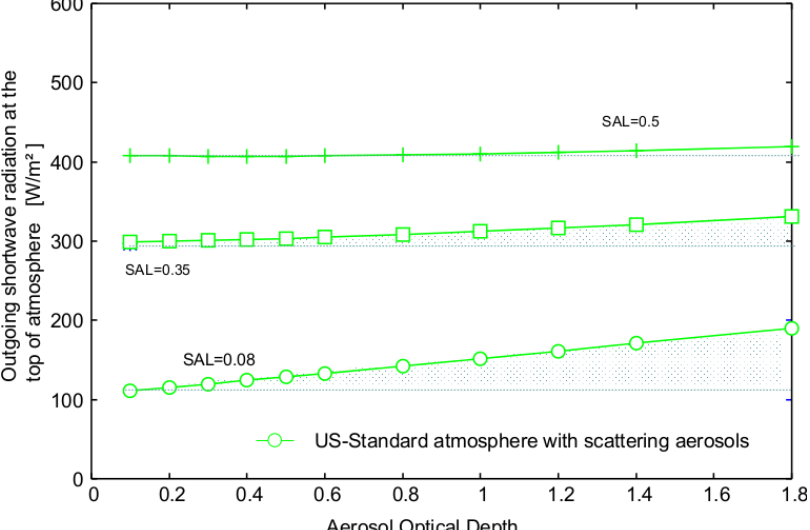
Figure 1. Results of the radiative transfer modeling with libRadtran for US-standard atmosphere, 335 DU ozone, 15 mm water vapor and scattering aerosols (ssa = 0.99). Increase of the aerosol optical depth leads to a significant increase for low to high surface albedo (SAL) values. Only for very high SAL values above 0.5 the increase is getting insignificant. For low to high SAL (up to ca. 0.45) it has to be expected that a temporary increase of AOD induced by specific aerosol events leads to an increase of cloud albedo (CAL)